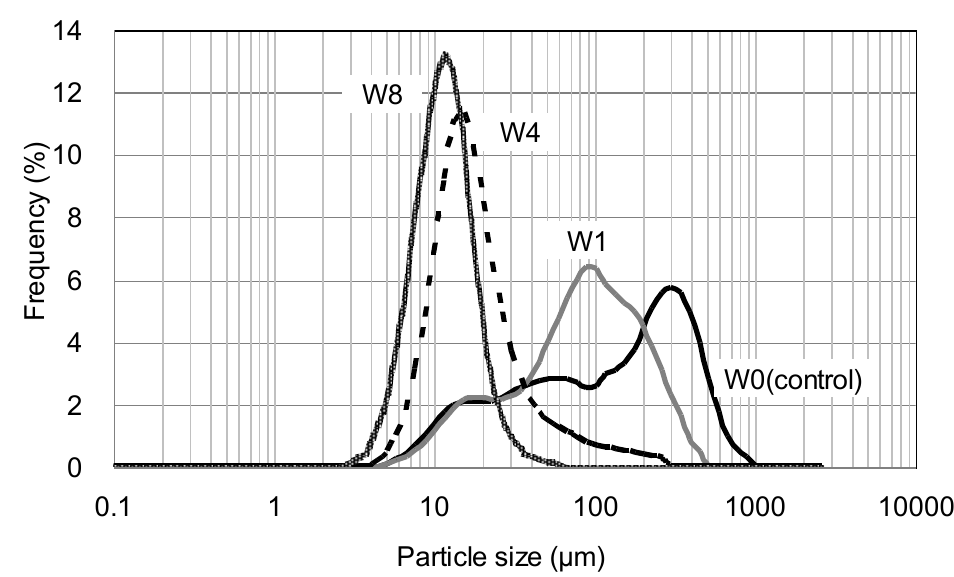
Figure 1. Particle size distributions are shown for W0, W1, W4, and